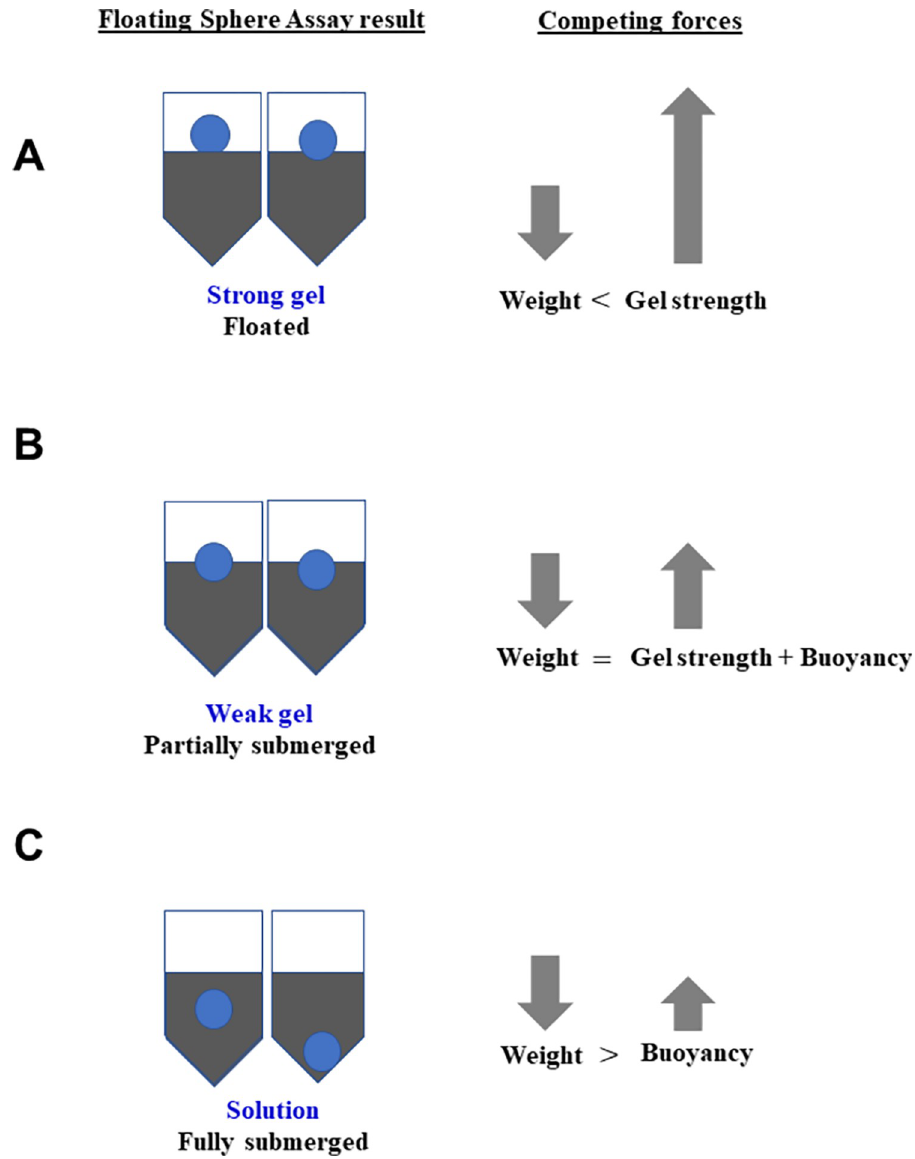
Fig 6. Physical principles underlying the floating sphere assay. Forces acting on the bead for the three possible outcomes of the Floating Sphere assay. (A) Bead is floating; (B) bead is partially submerged; (C) bead is completely submerged. Please see the text for